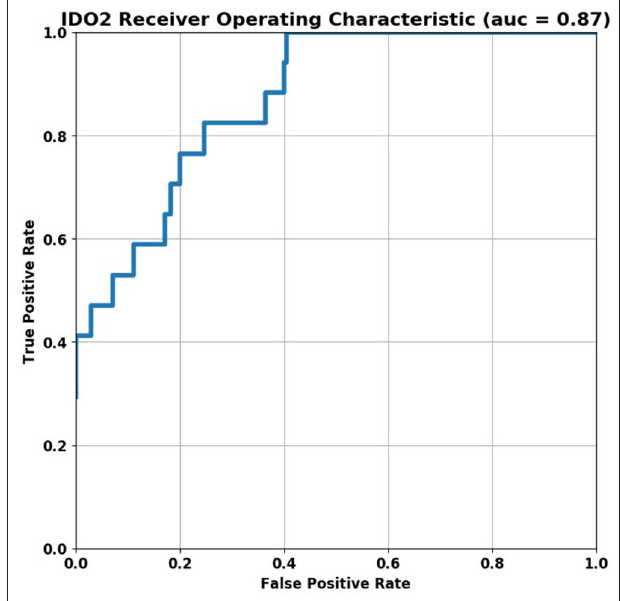
FIGURE 1 | ROC curve of detecting SvO2 < 40% using 30-min IDO2 average.